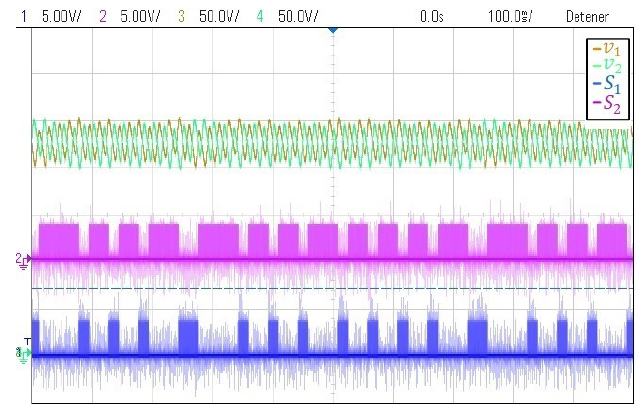
Figure 21. Waveforms of v 1 , v 2 , S 1 and S 2 for I s = 198mA.